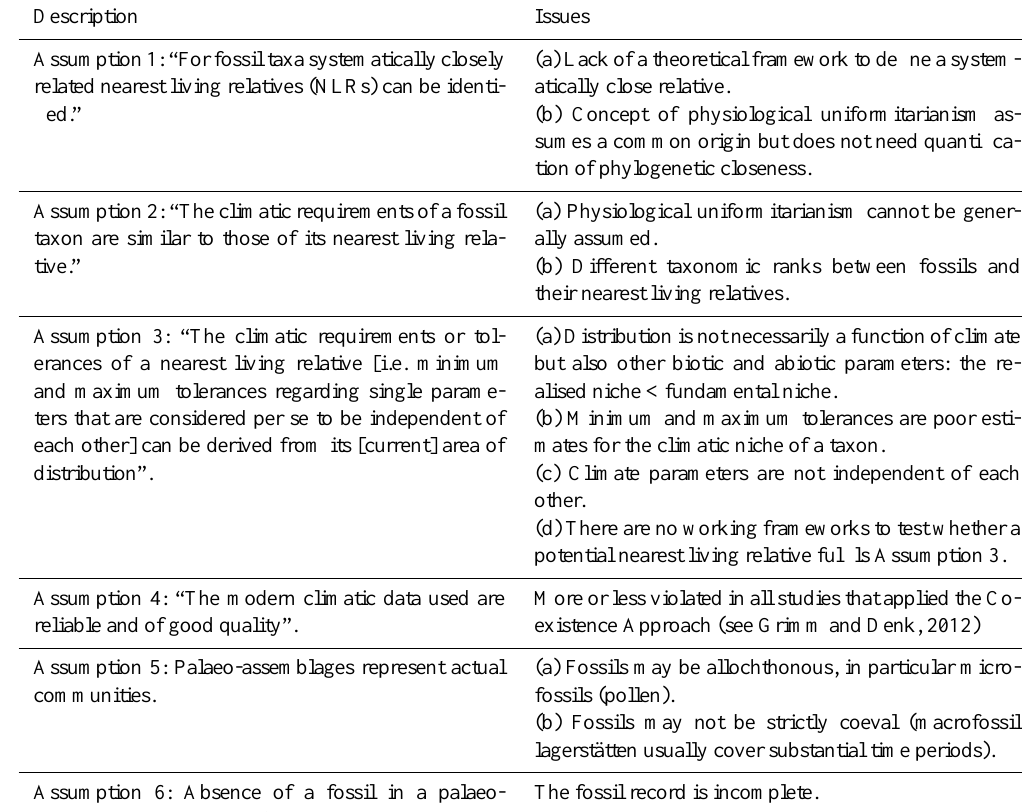
Table 1. The assumptions of the Coexistence Approach (quotations from Utescher et al., 2014).